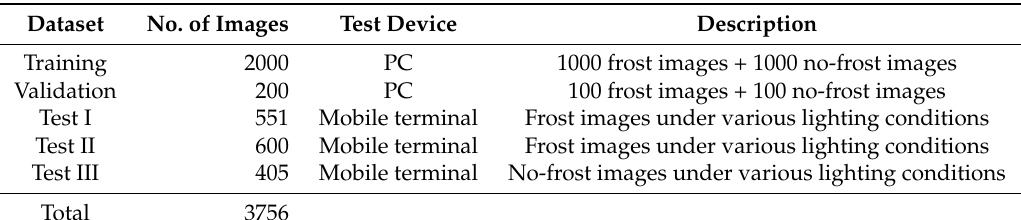
Table 2. Five sets of images used in this paper.